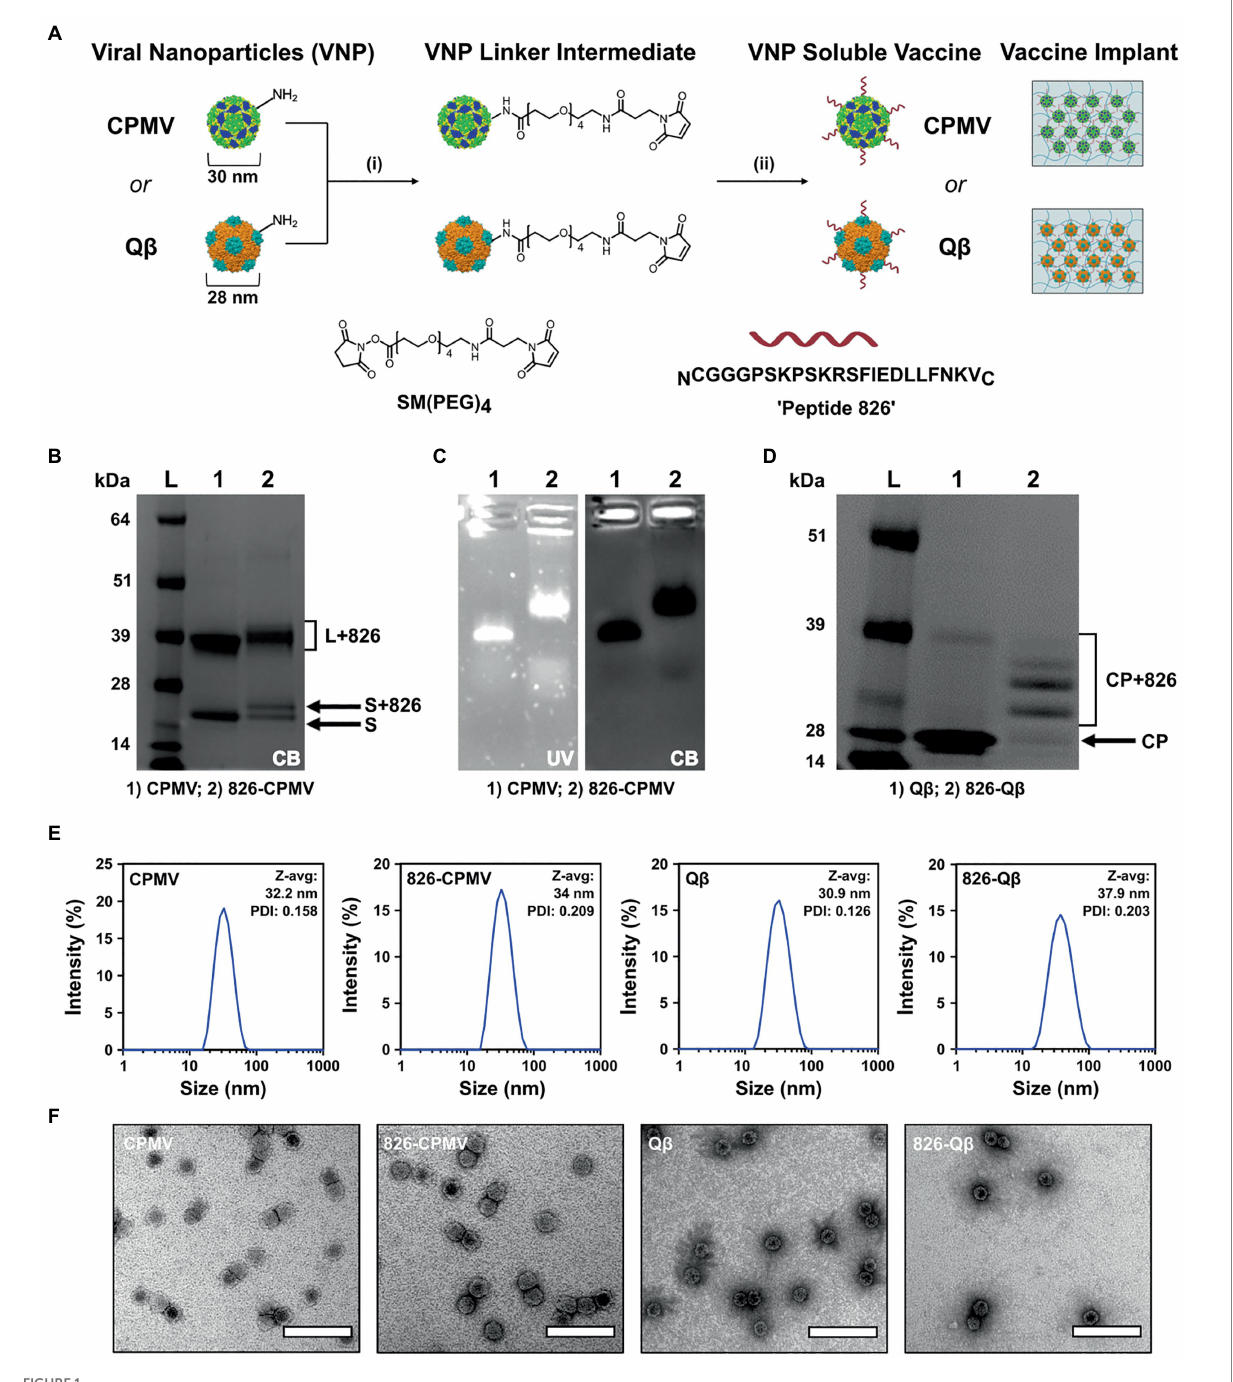
FIGURE 1 Characterization of 826-CPMV and 826-Q β particles. (A) Conjugation scheme for conjugate vaccines and their loading in implants, showing the structure of the SM(PEG) 4 heterobifunctional linker and epitope 826. (B) SDS-PAGE analysis of 826-CPMV showing the conjugated protein bands (S = small coat protein, L = large coat protein, +826 = conjugated peptide). (C) Analysis of 826-CPMV by 1.2% (w/v) agarose gel electrophoresis (gels stained with GelRed and Coomassie Brilliant blue). (D) SDS-PAGE analysis of 826-Q β showing the conjugated protein bands. (E) DLS spectra with Z-avg (d, nm) and polydispersity index (PDI) values for the peptide conjugates. (F) TEM images of the peptide conjugates negatively stained with 2% (w/v) uranyl acetate (scale bar = 100